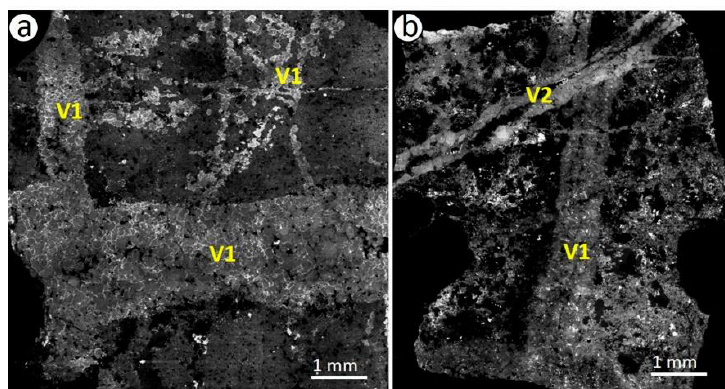
Figure 8. SEM-CL images of quartz veins (V1 and V2) in INT#1 ( a ) and in INT#2 ( b ).